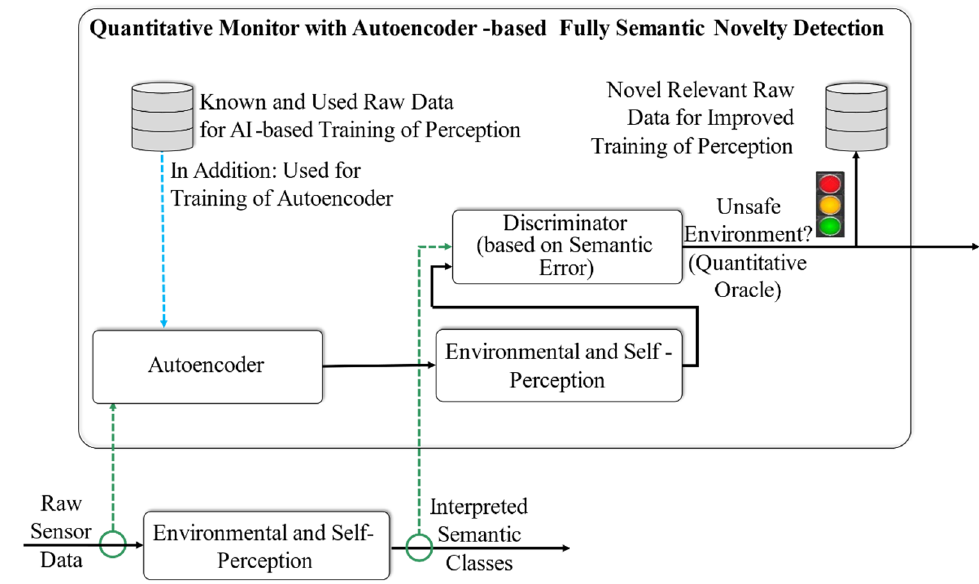
Figure 11. Quantitative monitor with fully semantic novelty detection.